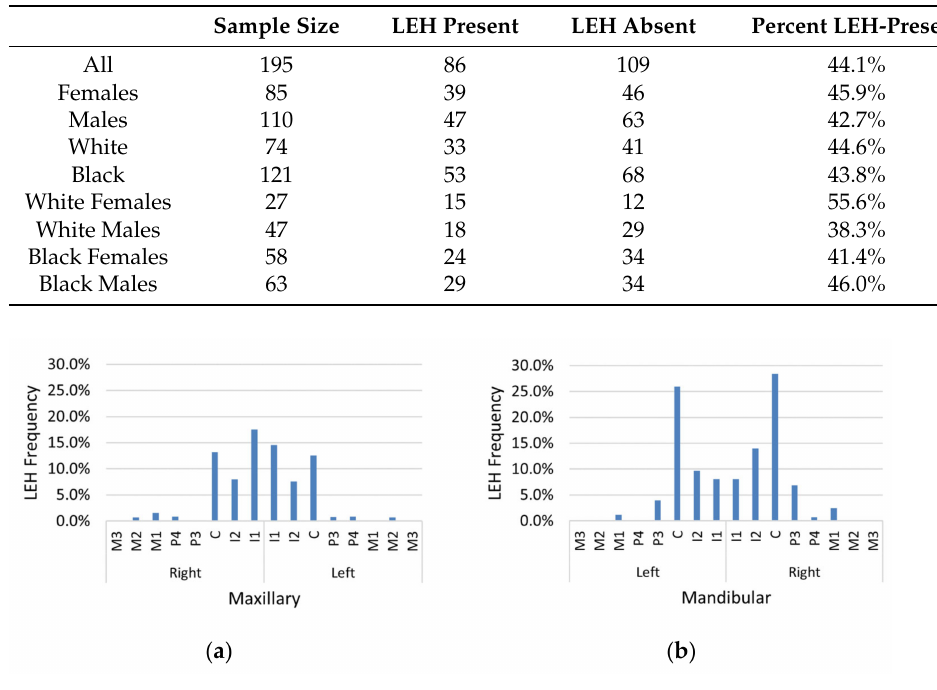
Figure 4. Presence of LEH frequency for maxillary ( a ) and mandibular ( b ) teeth.